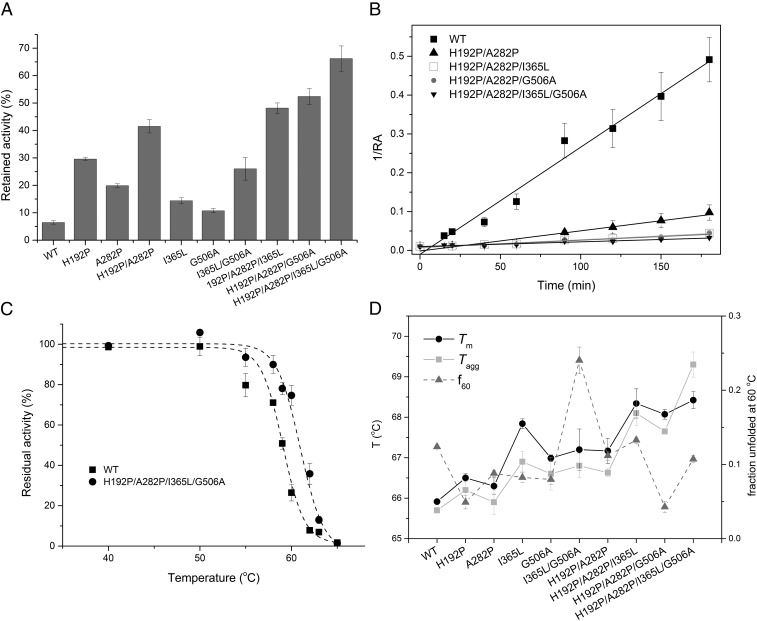
Thermal stability of TK and its variants. (A) Activity retained after heating at 60 °C for 1 h. Data were averaged from triplicate experiments and the SD is shown in parentheses. (B) Second-order degradation kinetics of TK variants at 60 °C. RA represents residual activity. WT, y = 0.00275x − 0.0085, R2 = 0.98; H192P/A282P, y = 0.00052x − 0.0016, R2 = 0.95; H192P/A282P/I365L, y = 0.000197x + 0.0076, R2 = 0.98; H192P/A282P/G506A, y = 0.000187x + 0.0075, R2 = 0.94; H192P/A282P/I365L/G506A, y = 0.000121x + 0.0099, R2 = 0.95. (C) Thermal-induced inactivation of WT and a quadruple variant. Enzymes in 100 µL of solution (2.4 mM TPP, 9 mM MgCl2, and 50 mM Tris⋅HCl, pH 7.0) were incubated at different temperature from 22 to 65 °C for 15 min and assayed for residual activity at 22 °C. The activity incubated at 22 °C was considered to be 100%. (D) Tm, Tagg, and fraction unfolded at 60 °C (f60) for WT and variant TKs.